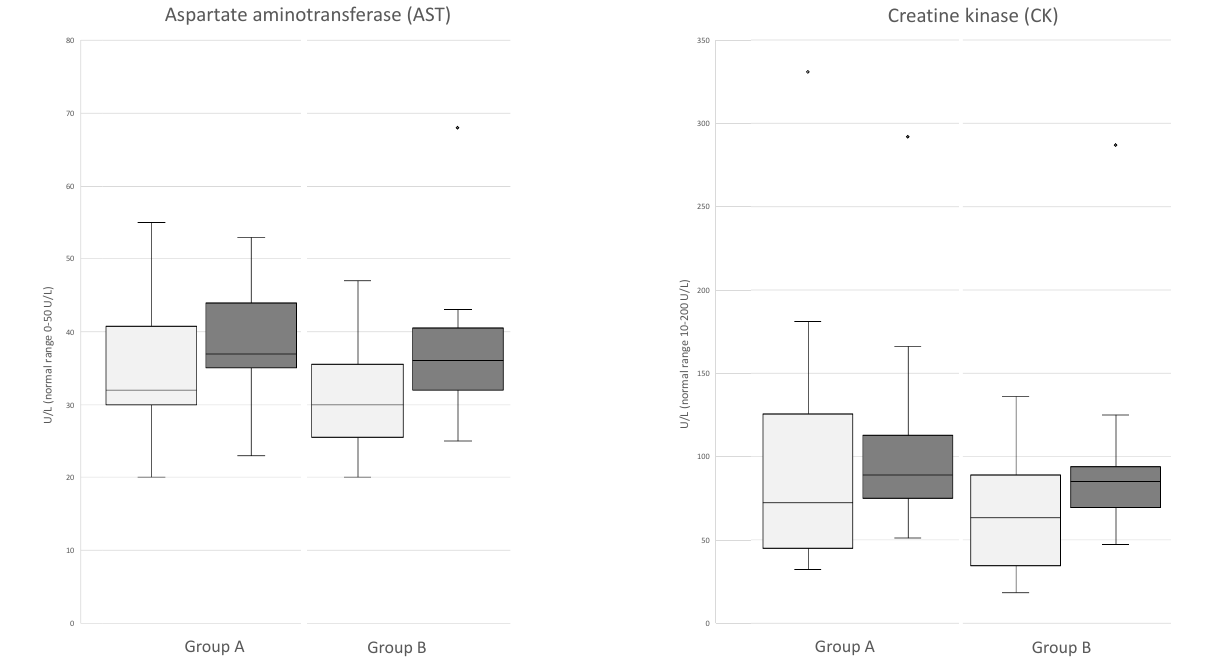
Figure 2. Boxplots of aspartate aminotransferase (AST) and creatine kinase (CK) monitored before and 2 h after activity in Group 1 ( A ) and Group 2 ( B ). No statistical differences were